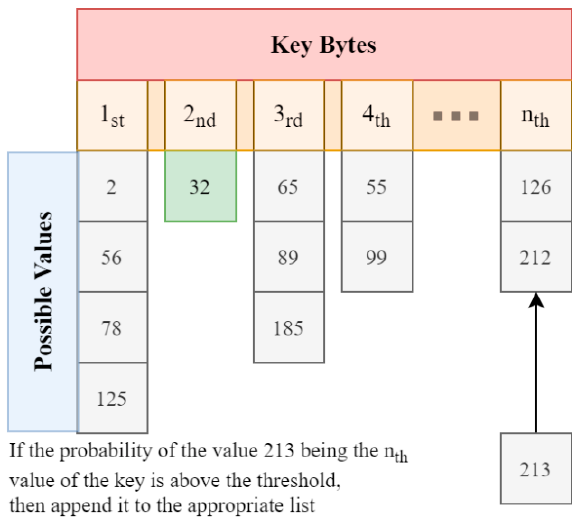
Figure 12. Generating the list of possible values for each byte of the key. Prime + Count